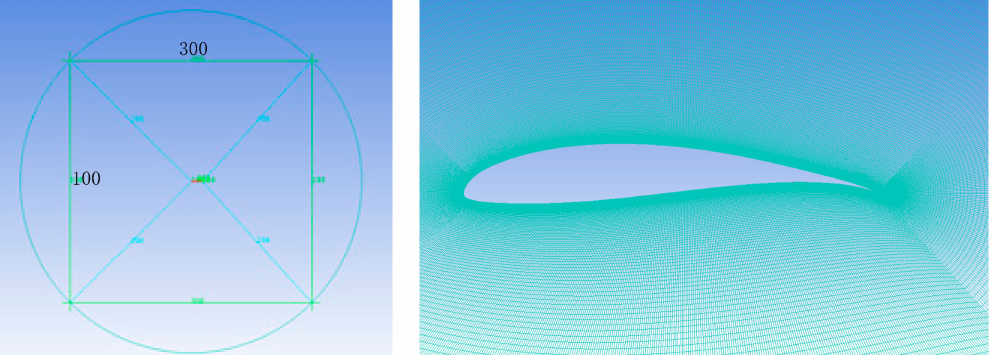
Figure 3. Mesh of the